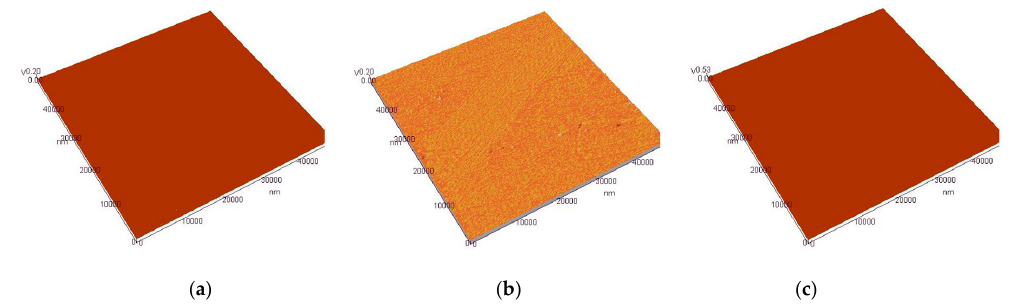
Figure 9. AFM topographies of Cr–Ni coatings with different mass ratios of Cr and Ni.( a ) AFM